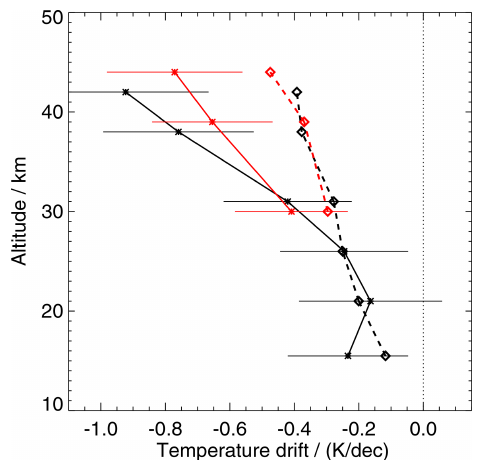
Figure 5. Mean monthly MIPAS temperature differences between version V8R_T_261 and V5R_T_220 for August 2010. Figure 6. Temperature drift between MIPAS V5 and AMSU (solid